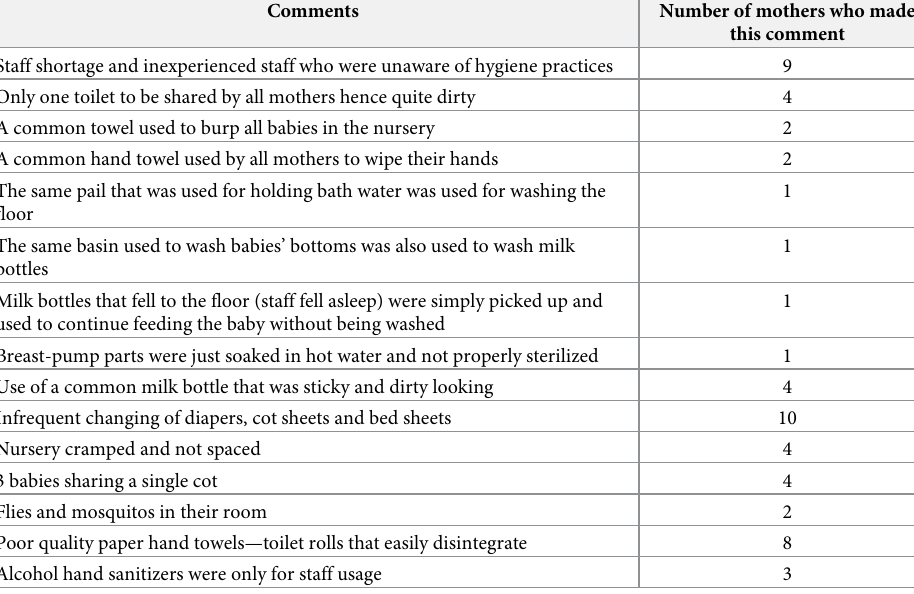
Table 4. Comments related to hygiene in confinement